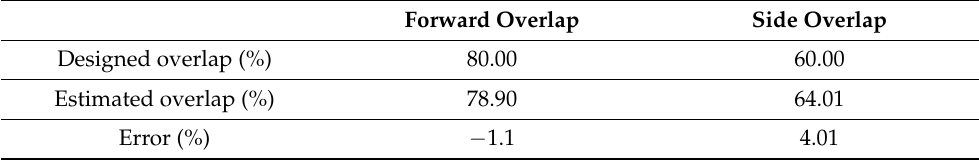
Figure 12. Overlap estimation among images. Table 7. Overlap accuracy of the simulator.